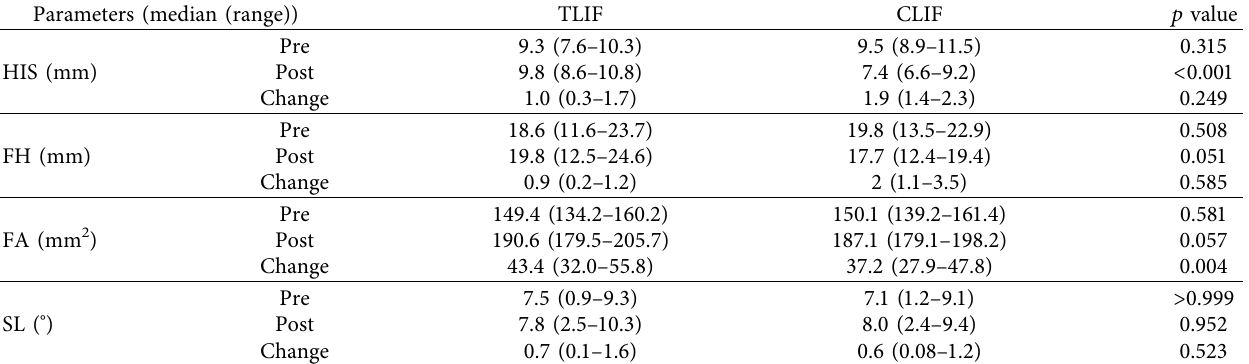
Table 3: Radiological results of patients in the TLIF group and CLIF